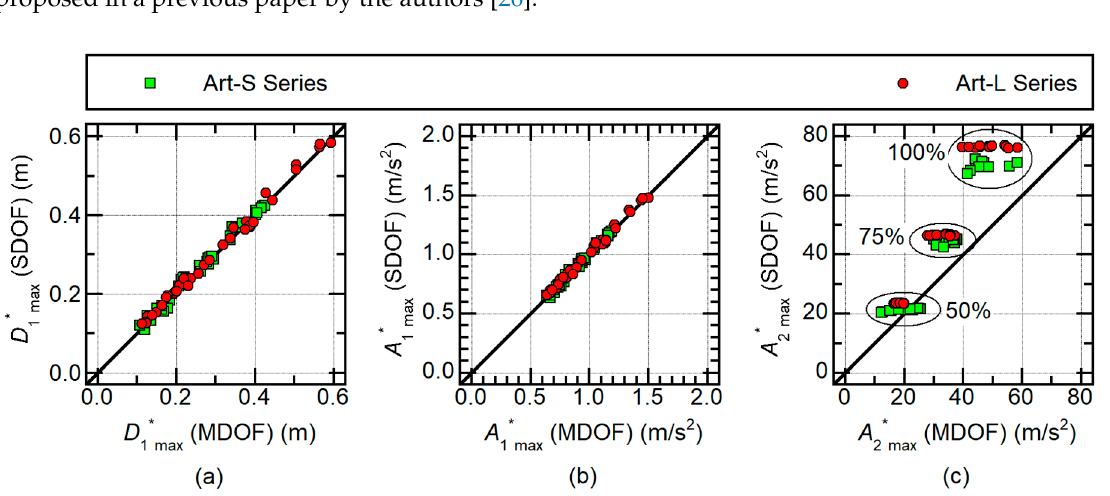
Figure 18. Comparison of maximum modal responses: ( a ) equivalent displacement of first mode; ( b ) equivalent acceleration of first mode; ( c ) equivalent acceleration of second mode.